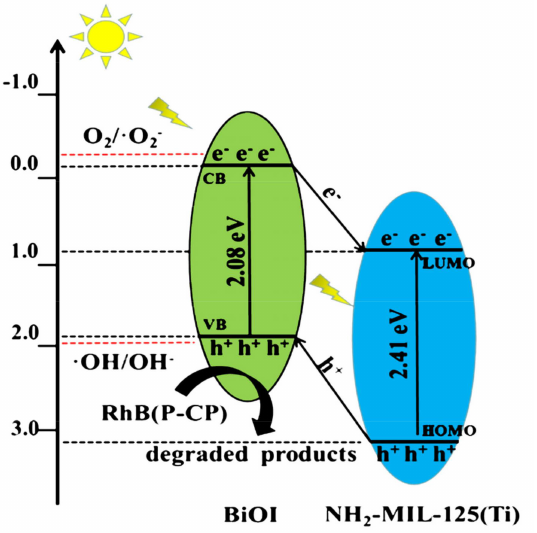
Figure 12. Suggested mechanism for the photocatalytic degradation of RhB and P-CP by BiOI/NH 2 - MIL-125(Ti) under visible